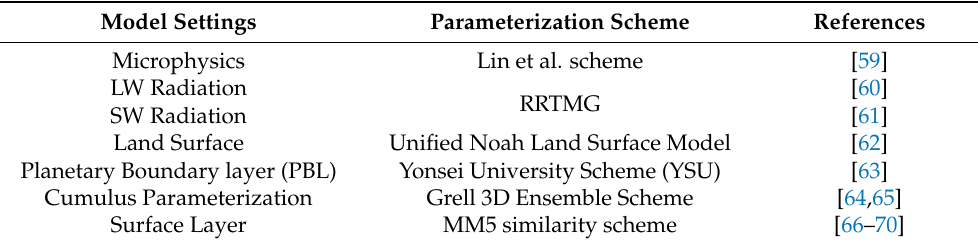
Table 3. The WRF model physical parameterizations used in this study. Model